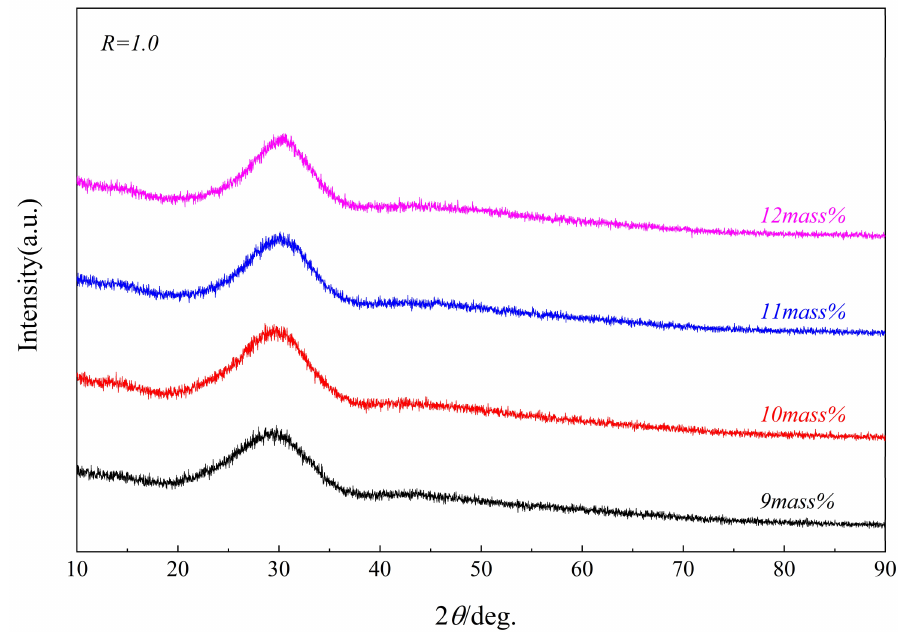
Figure 4. XRD patterns of samples with different Al 2 O 3 glass